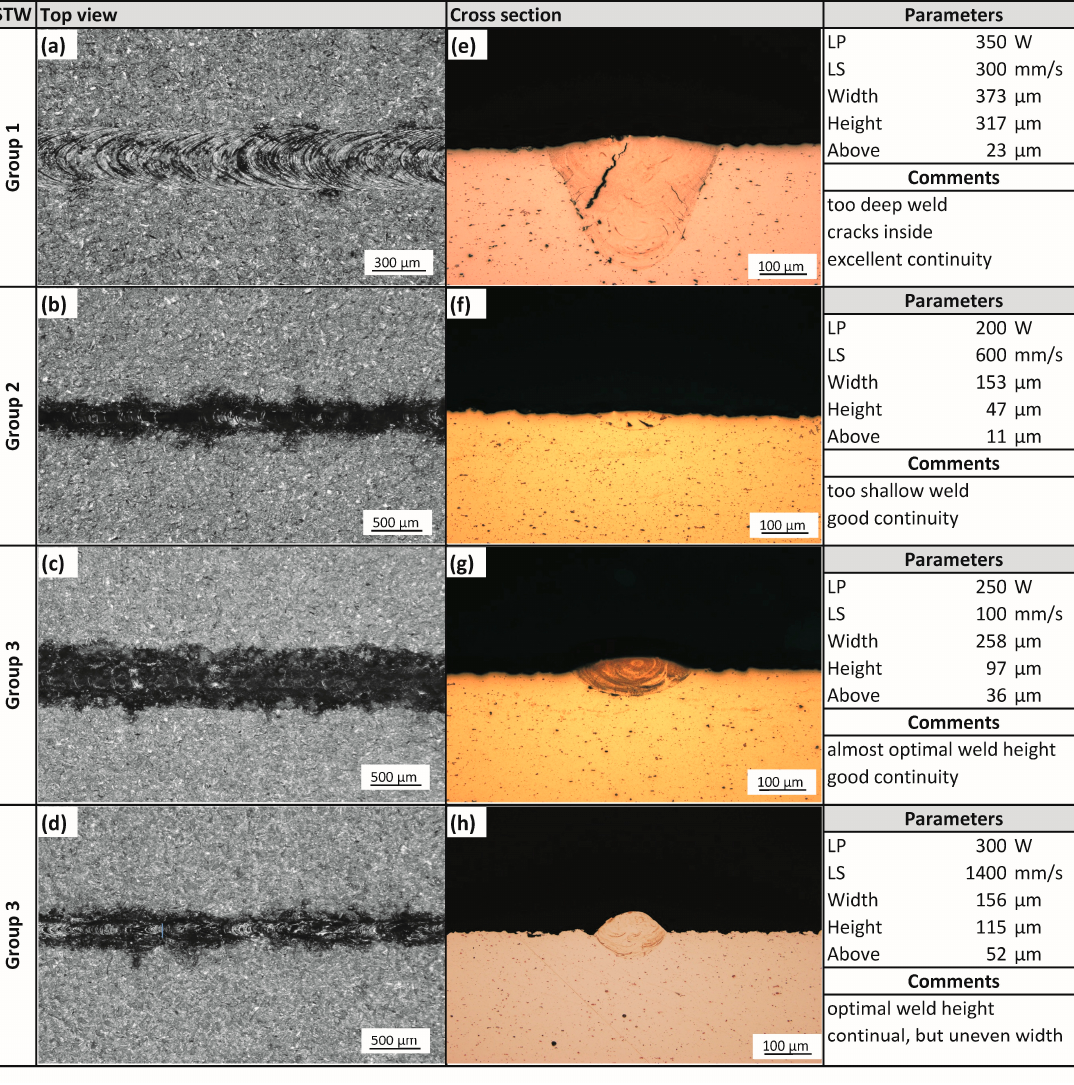
Figure 5. Representative samples of single track weld for each group of welds; ( a – d ) top view; ( e – h ) cross